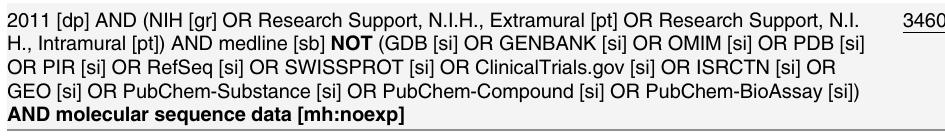
Table 4. PubMed search identifying articles in PMC. 2011 [dp] AND (NIH [gr] OR Research Support, N.I.H., Extramural [pt] OR Research Support, N.I. H., Intramural [pt]) AND medline [sb] NOT (GDB [si] OR GENBANK [si] OR OMIM [si] OR PDB [si] OR PIR [si] OR RefSeq [si] OR SWISSPROT [si] OR ClinicalTrials.gov [si] OR ISRCTN [si] OR GEO [si] OR PubChem-Substance [si] OR PubChem-Compound [si] OR PubChem-BioAssay